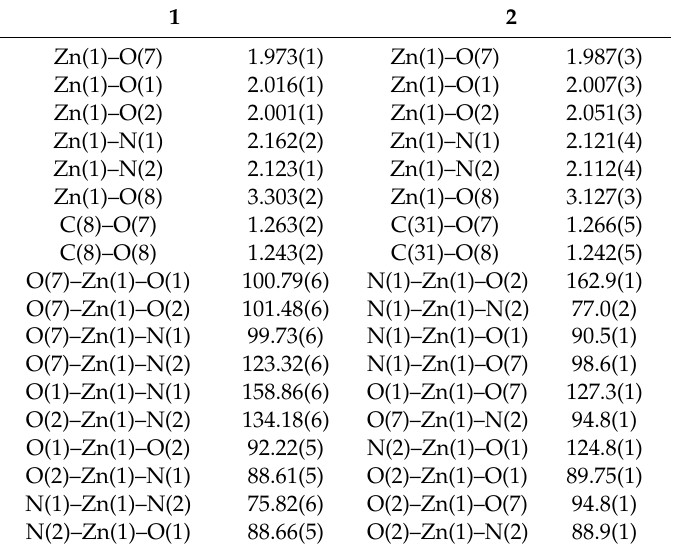
Table 1. Relevant structural parameters (Å, ◦ ) for [Zn(CH 3 COO)(cur)(bpy)] ( 1 ) · CH 3 OH · 2H 2 O